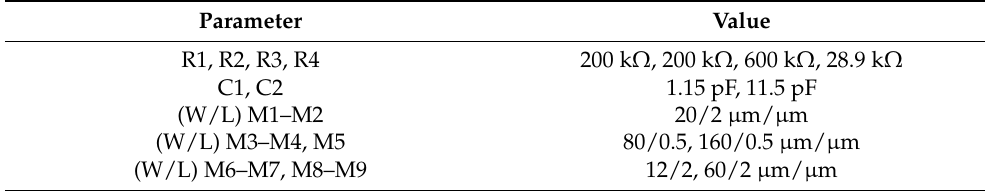
Table 2. Design parameters for LDO.